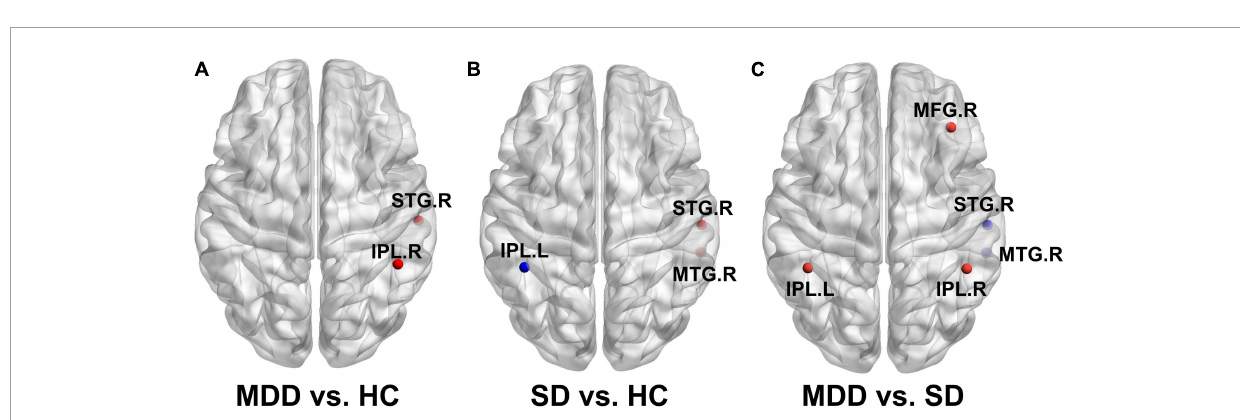
FIGURE3 Brain regions with significantly different DC values in inter-group comparisons. (A) Brain regions with significant differences in DC between the MDD and HC groups; (B) brain regions with significant differences in DC between the SD and HC groups; (C) brain regions with significant differences in DC between the MDD and SD